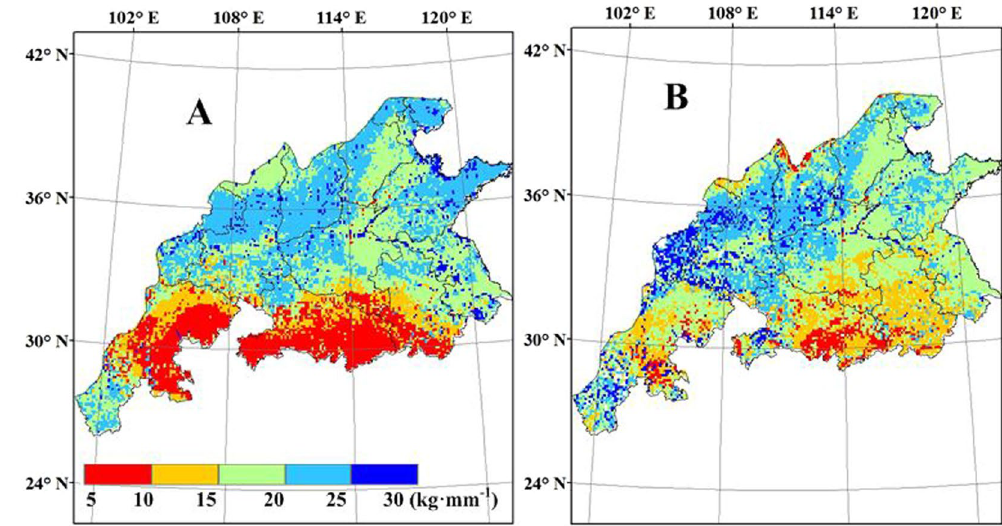
Figure 11. Average water limiting index (WLI) from 1998 to 2008 in the main winter wheat production regions of China, ( A ) CERES-Wheat; ( B ) WheatGrow (This figure was created by ArcGIS 9.3, http://www.esri.com/